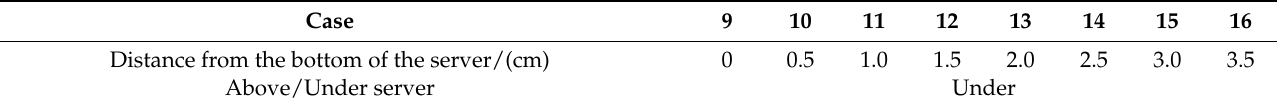
Table 4. The distance analysed of bottom mounted HPEs between the